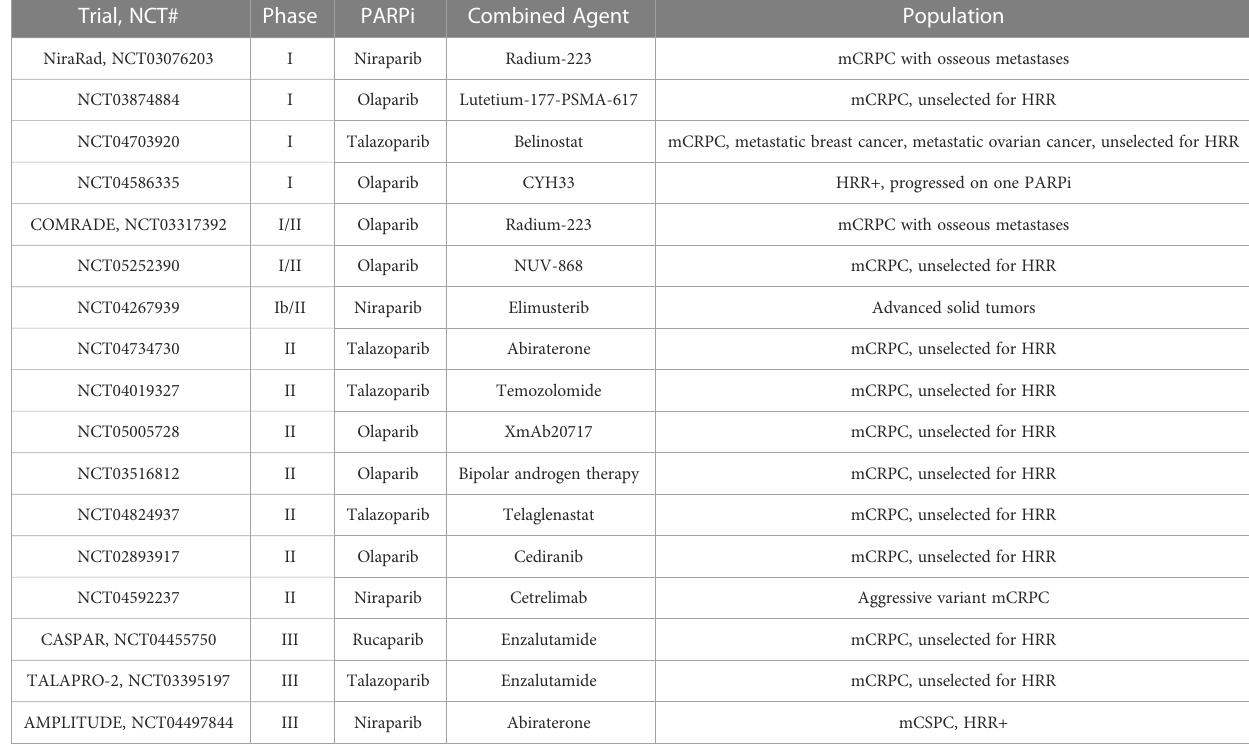
TABLE 3 Ongoing trials of PARPi combination therapies in